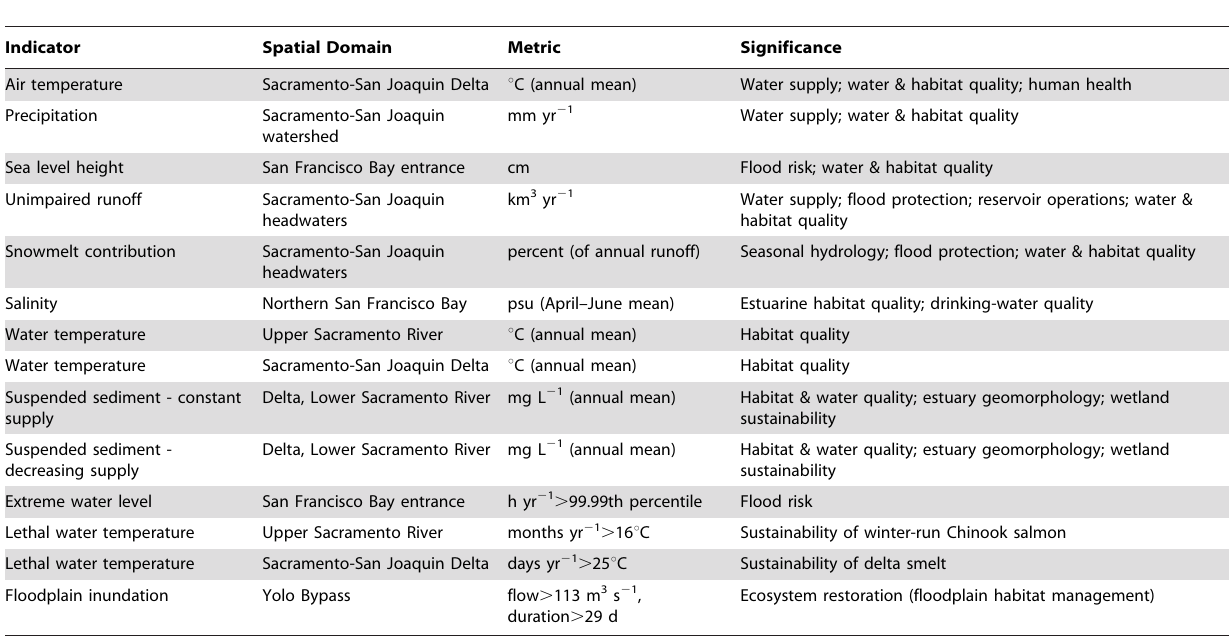
Table 1. Environmental indicators analyzed directly (top 10; see Figs. 2–3) or exceedences of thresholds (bottom 4; see Fig. 4), with corresponding spatial domains (see Fig. 1), units of measurement, and social/ecological